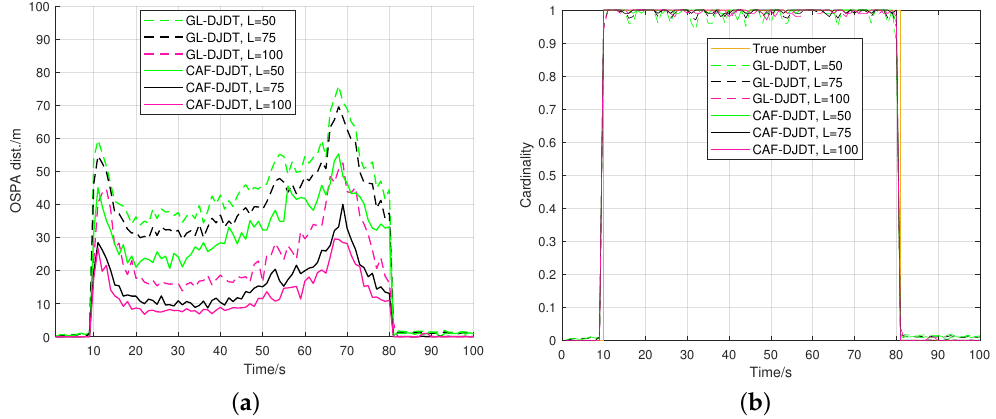
Figure 4. Comparision of two DJDT methods with a different number of snapshots. ( a ) OSPA errors of two DJDT methods with a different number of snapshots; ( b ) Cardinality of two DJDT methods with a different number of snapshots The error of the estimated time-varying α j is reflected by the RMSE of α 1 for the first re- k k ceiver. The results versus time from 10 s to 80 s are shown in Figure 5 with SNR = − 13, − 12, and − 10 dB. The errors in the latter half of the period rise and gradually converge. This can be interpreted by the topology of the track, transmitter, and receivers becoming harder to observe.